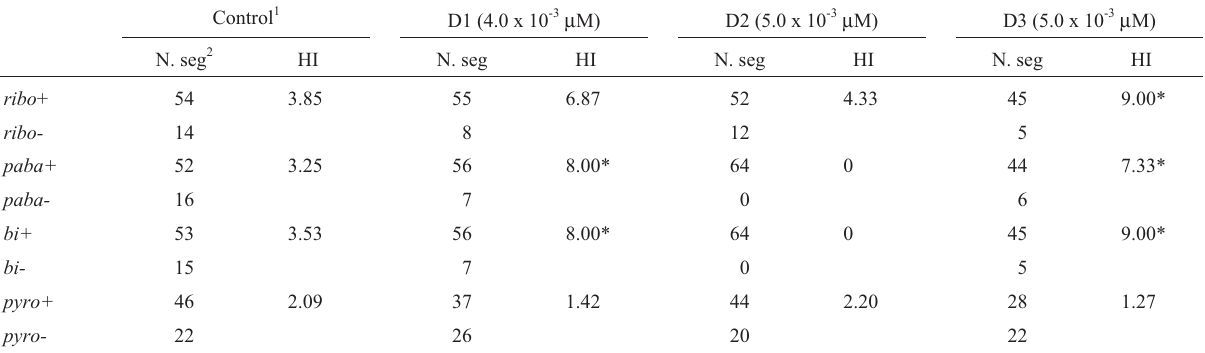
Table 2 - Homozygotization Indexes (HI) of markers from the Z1 // A757 diploid strain exposed to 4.0 x 10 -3 and 5.0 x 10 -3 µ M of ethidium bromide.